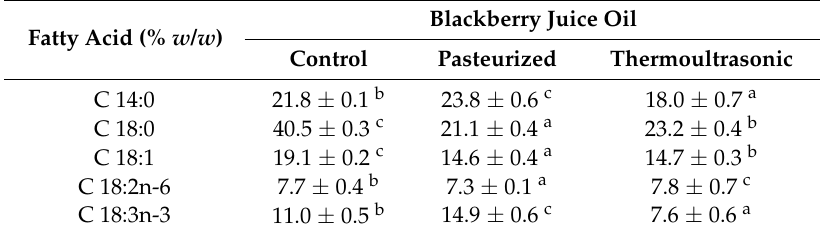
Table 3. Fatty acid composition of the oil extracted with hexane from experimental blackberry juices. Fatty Acid (% w / w )